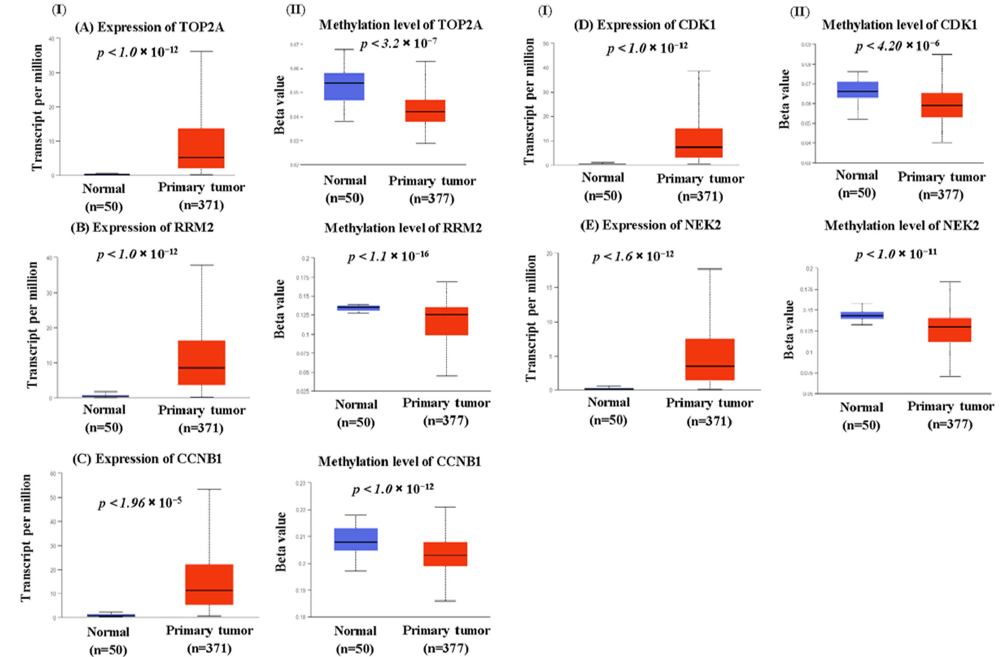
Figure 6. The status of the genes expression ( I ) and methylation ( II ) of the hub genes in liver cancer. The expression and promoter methylation pattern of ( A ) TOP2A , ( B ) RRM2, ( C ) CCNB1, ( D ) CDK1, and ( E ) NEK2 in the primary liver tumors ( n = 377) as compared to the normal samples ( n = 50) using TCGA samples.